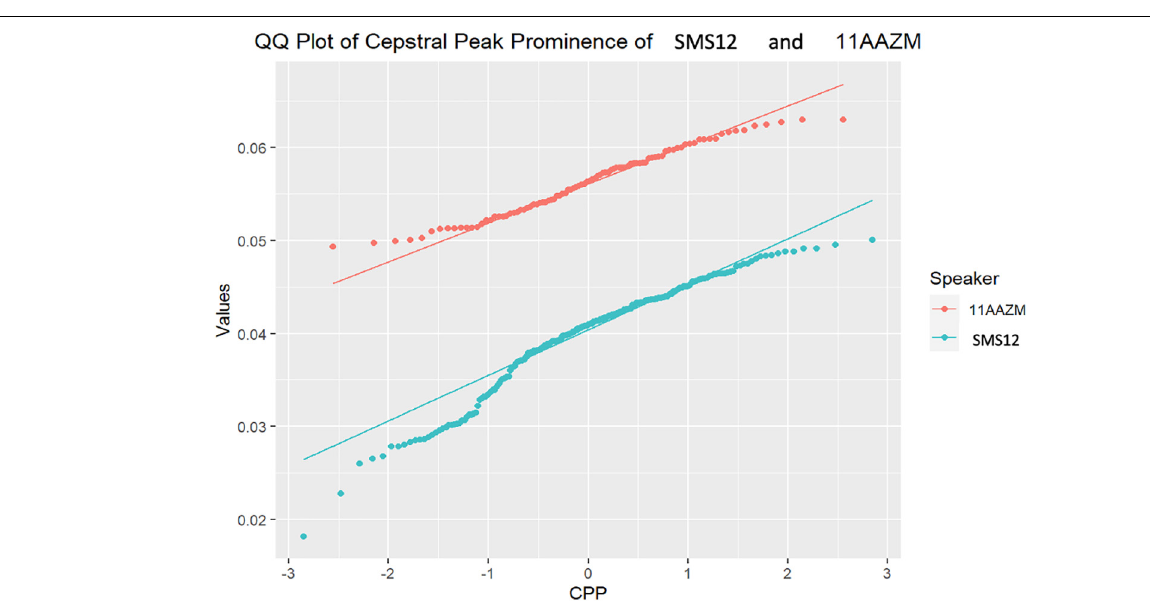
FIGURE 7 | Q–Q plot of SMS12 and 11AAZM cepstral peak prominence (CPP)